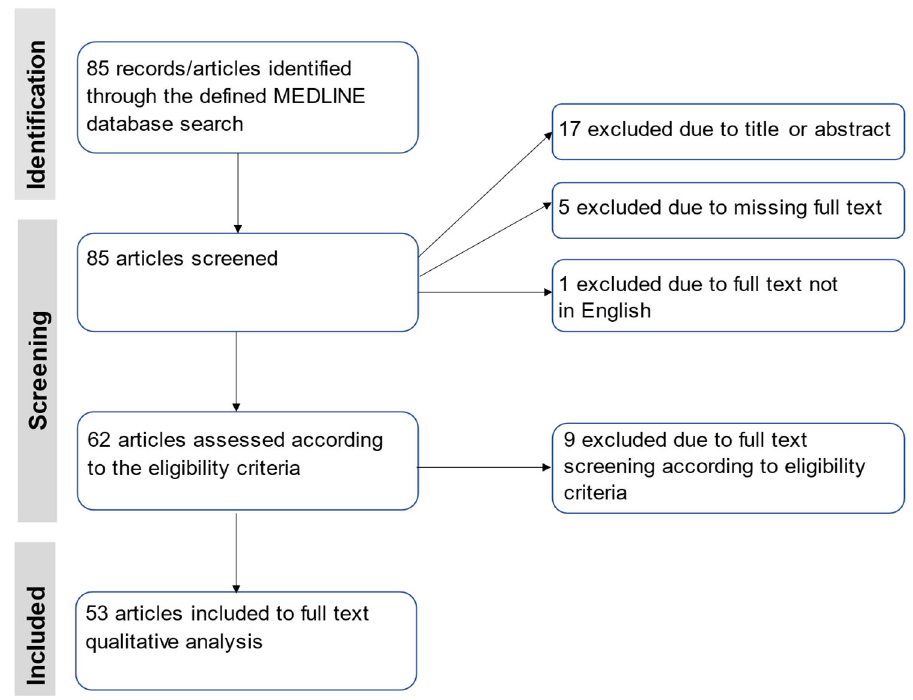
Figure 1. Preferred Reporting Items for Systematic Reviews and Meta-Analyses (PRISMA) flow diagram showing search process overview.